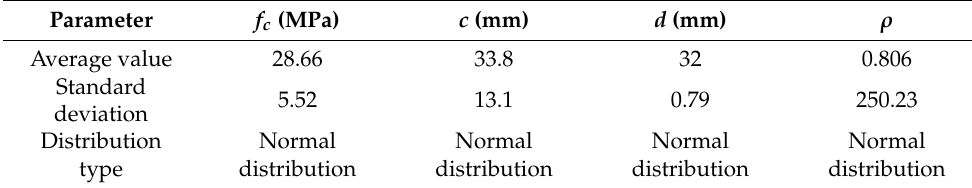
Table 1. Averages and standard deviations of concrete parameters.